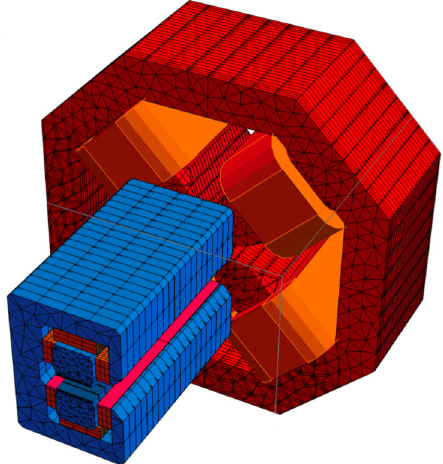
FIG. 1. View of a 3D magnetic model of interacting moderate gradient quadrupole (in red) and permanent magnet dipole module (in blue). The DL dipoles are built with five modules with different field